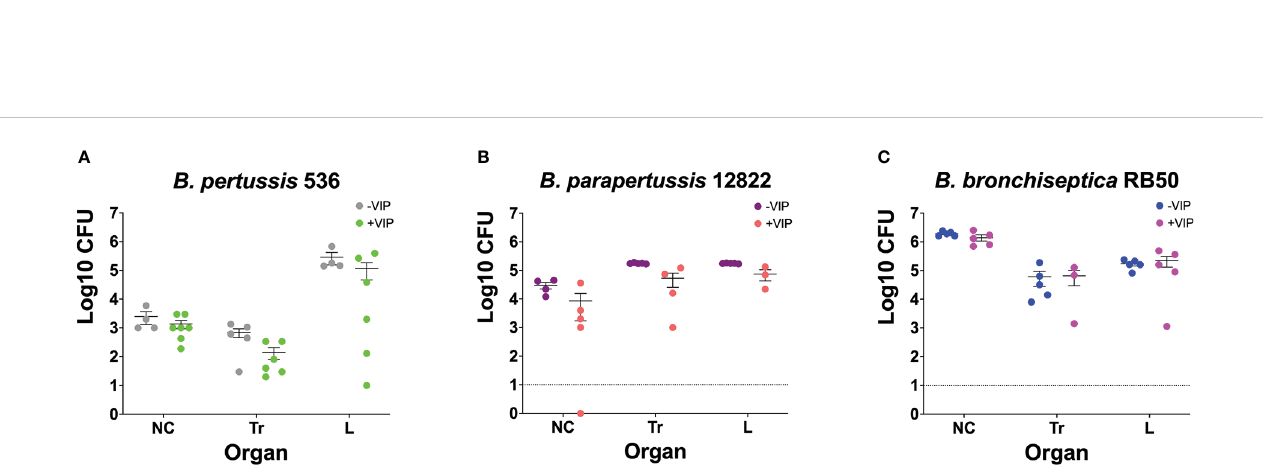
FIGURE 2 Pre-incubation with VIP does not promote bacterial colonization. Overnight cultures of B. pertussis BP536 (A) , B. parapertussis 12822 (B) , and B. bronchiseptica RB50 (C) , were done in DMEM supplemented with 10% FBS. The overnight cultures were treated with or without 200nM of VIP, as indicated in the legends of each fi gure. After 24 hours, these cultures were used to intranasally inoculate mice with 30 m l of PBS containing 5x10 5 CFUs of bacteria. At day 3 post-challenge, CFUs were enumerated by counting colonies in BGS agar from the nasal cavity (NC), trachea (Tr), and lungs (L). Two- way ANOVA analysis was performed to evaluate statistical differences. Data was comprised of two independent experiments. The bars represent the mean ± SD, with each data point representing one mouse (n = 4-7 mice per condition).